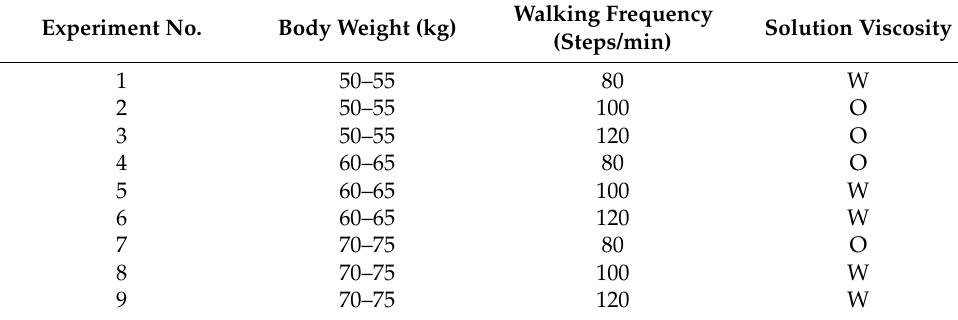
Table 1. Orthogonal experimental layout. Experiment